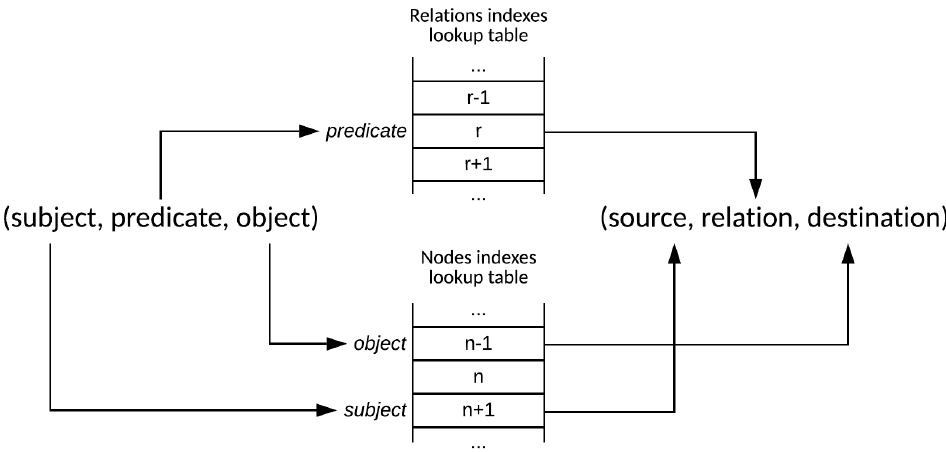
Figure 3. Process of translation from the RDF statement to an edge tuple.